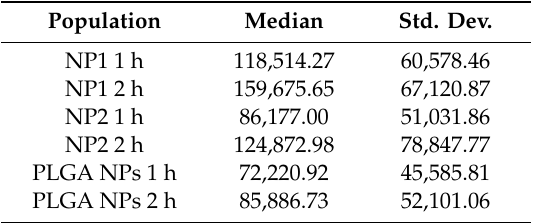
Table 3. Fluorescent intensity score measured by ImageStream ® X. The fluorescence median values indicate the amount of NPs really internalized by cells and are correlated to the histograms reported in Figure 7C.